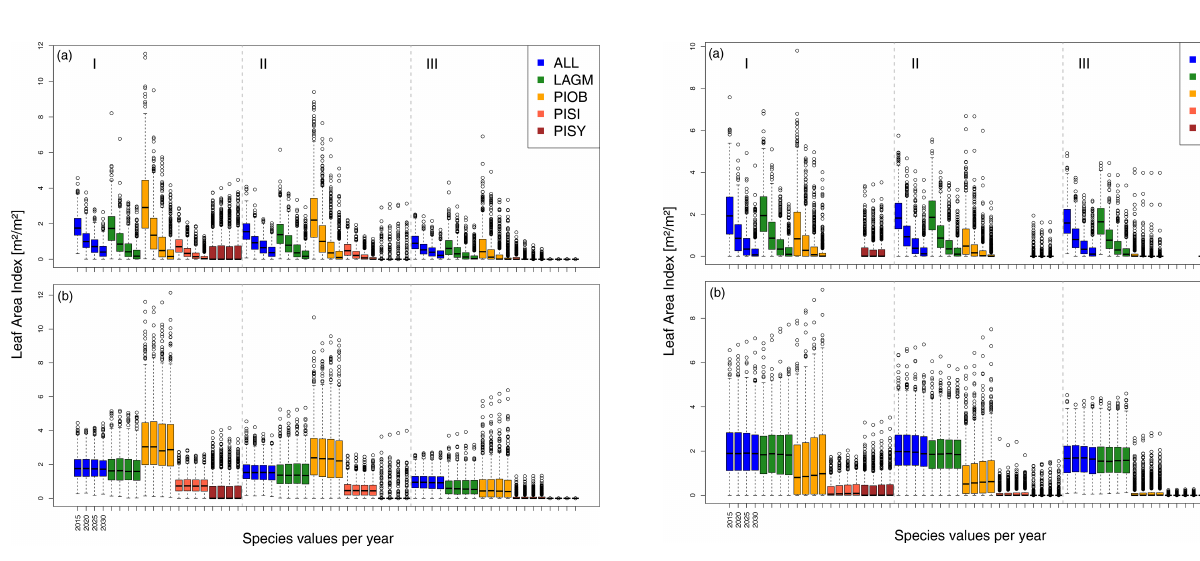
Figure 5. Leaf area index (LAI) values at Lake Khamra for the three areas within the simulation areas (I, II, III) on the same plot at which CryoGrid was called (upper row) and only LAVESI runs (lower row). LAGM: Larix gmelinii ; PIOB: Picea obovata ; PISI: Pinus sibirica ; PISY: Pinus sylvestris .